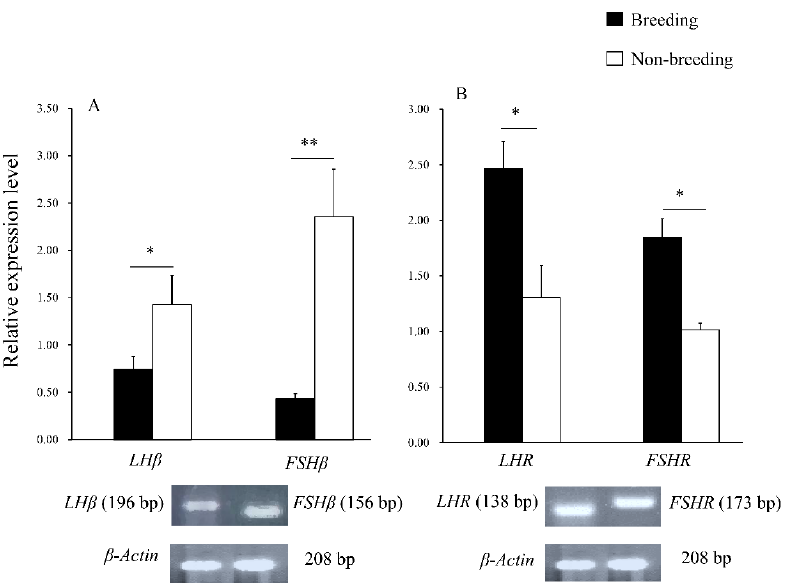
Figure 4. RT-PCR analysis of the mRNA of plateau zokor ( Eospalax baileyi ) during the breeding and non-breeding seasons; ( A ): the mRNA relative expression levels of LH β and FSH β in the pituitary gland of plateau zokor ( B ): the mRNA relative expression levels of LHR and FSHR in the testes of plateau zokor. Bars represent the means ± standard deviation of two independent experimental treatments ( n = 10 per season). Means within the columns with different marks indicate a significant difference; * represents p < 0.05, ** represents p < 0.01. Table 2. Comparison of nucleotide sequence homology between the plateau zokor ( Eospalax baileyi ) and rats ( Rattus rattus ), mice ( Mus musculus ), marmots ( Marmota marmota ), and humans ( Homo sapi- ens ).